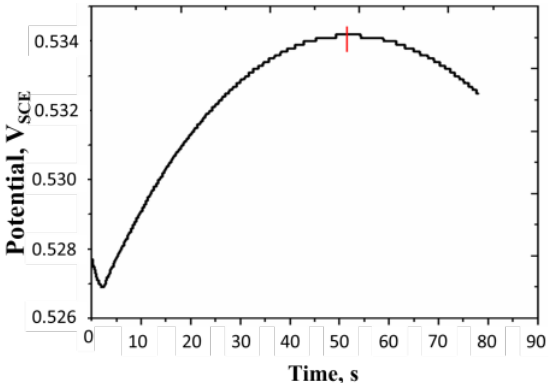
Figure 10. Linear current sweep chronopotentiogram of a polyaniline film. Surface aerated system, concentration of H 2 SO 4 = 0.5 M, surface mass density of the film = 16.41 g m −2 , temperature = 25 °C. Initial current = +0.8 mA, current scan rate: 5 × 10 −3 mA s −1 , turning time = 52 s. All potentials are reported with respect to SCE.